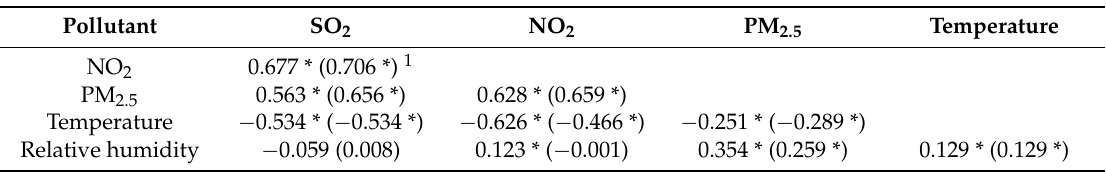
Table 2. Pearson correlation coefficients between outdoor air pollutants and meteorology parameters in the urban and suburban areas of